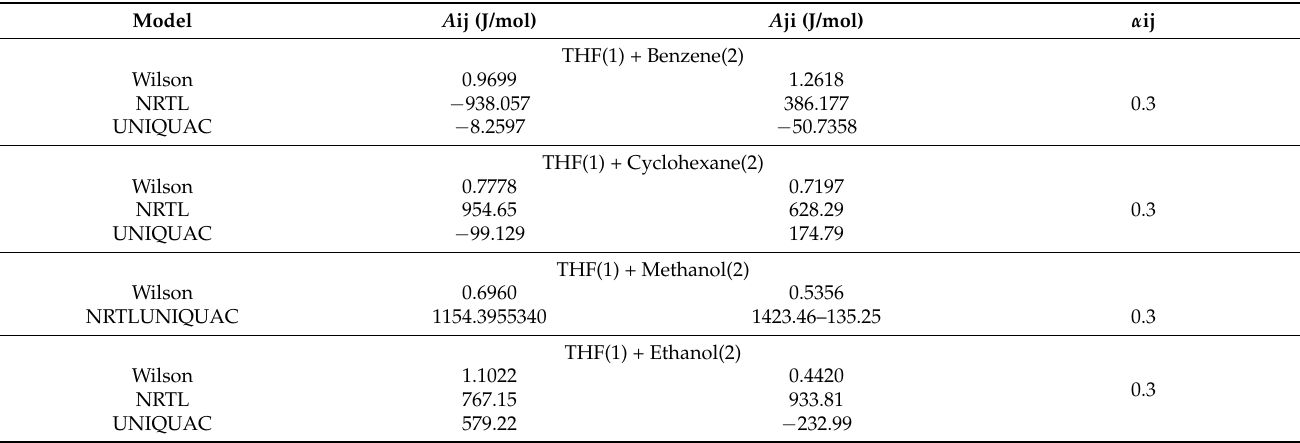
Table 6. The results of binary parameters using OF